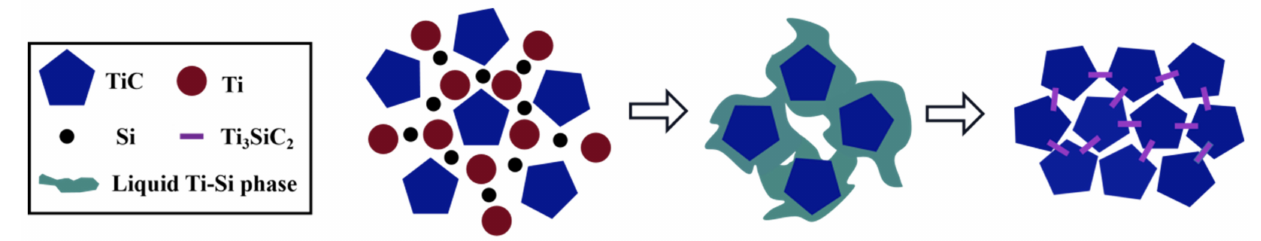
Figure 3. Schematic diagram of a proposed sintering process and microstructure evolution for TiC-based ceramics when introducing Ti 3 SiC 2 by Ti, Si